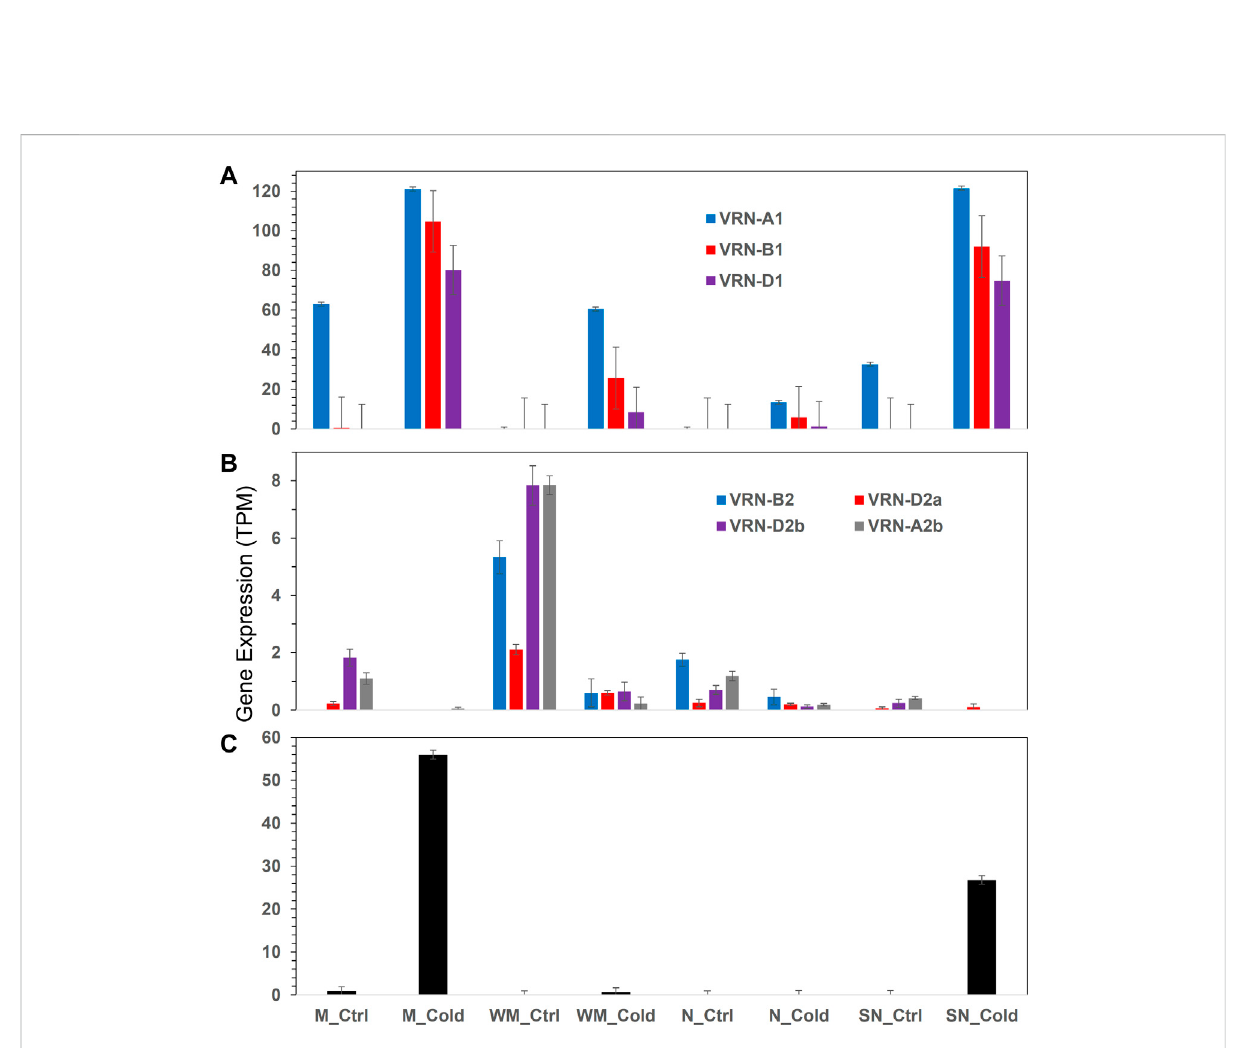
FIGURE 6 Expression of vernalization genes in different experimental conditions. (A) VRN1 , (B) VRN2 , (C) VRN3 . Error bars are one standard error of the mean of three replicates. More details are available in Supplementary File